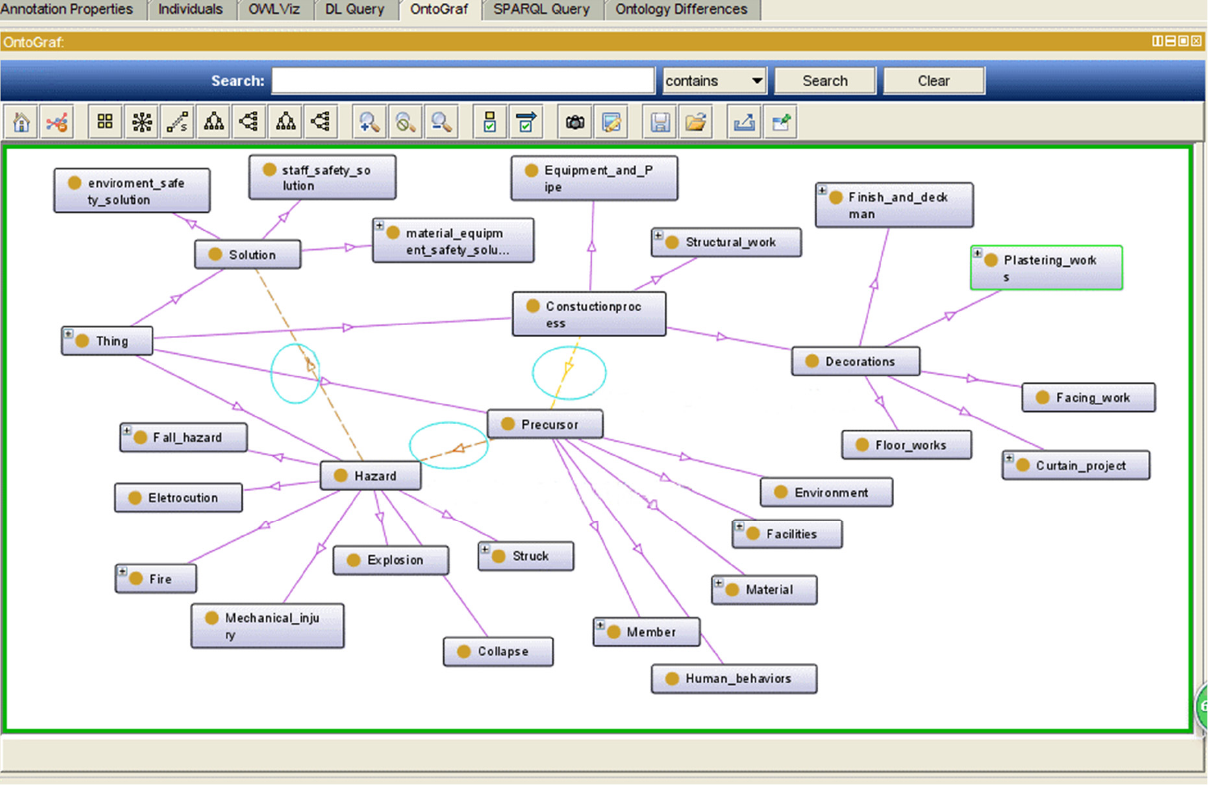
Table 4. Construction activity data type attribute definition.